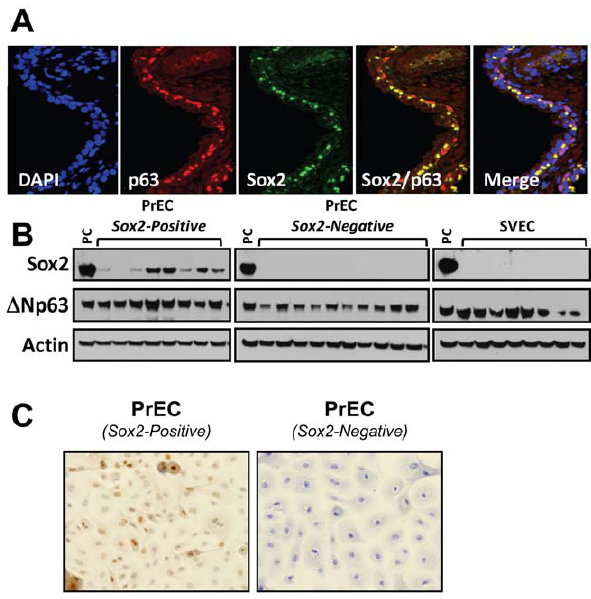
Figure 2. Sox2 is expressed in the majority of normal basal- epithelial cells, and cultures derived from prostate epithelial cells (PrECs) are either uniformly Sox2-Positive or Negative. A ) Immunofluorescent co-staining of Sox2 (green) with the basal-specific marker p63 (red), showing that 75% of normal basal-epithelial cells are positive for both Sox2 and p63 (yellow) while the remaining 25% are Sox2-negative (red). DAPI staining highlights nuclei (representative images of normal prostate epithelium acquired from three different individual patient specimens). B ) Western blotting of a series of patient- derived Prostate (PrEC) and Seminal Vesicle (SVEC) epithelial sell (PrEC) cultures demonstrates that a portion of these cultures express detectable Sox2, while other PrEC and all SVEC cultures do not. C ) Immunocytochemical staining of Sox2 showing uniform nuclear Sox2 expression in Sox2-positive PrECs and lack of Sox2-positive cells within Sox2-negative PrECs (representative images of three independent